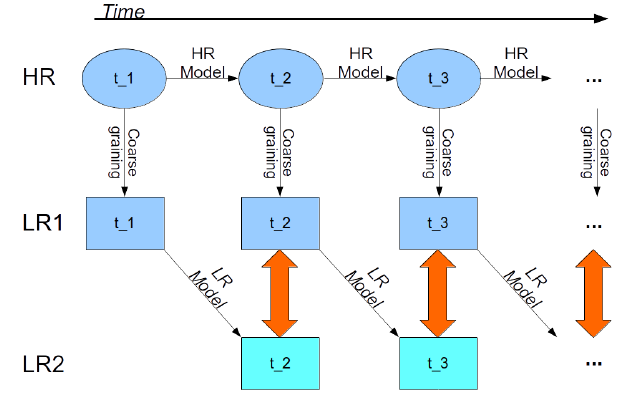
Figure 2. Schematic of the training data generation process. A HR run is coarse grained to LR to generate the model truth. Each model truth state is integrated forward for one time step using LR dynam- ics. The difference between the obtained states and corresponding model truth defines the desired network output (red arrows), while the preceding model truth defines the network input.